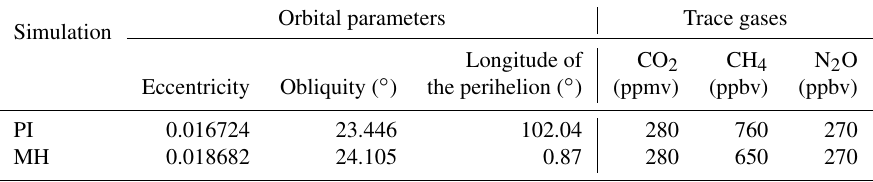
Table 2. Earth’s orbital parameters and trace gases as recommended by the PMIP3 project.